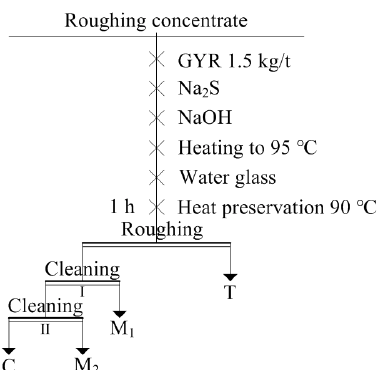
Figure 1. Flowsheet of scheelite heating flotation (concentrates (C), middlings (M) and tailings (T)). Minerals 2018 , 8 , x FOR PEER REVIEW